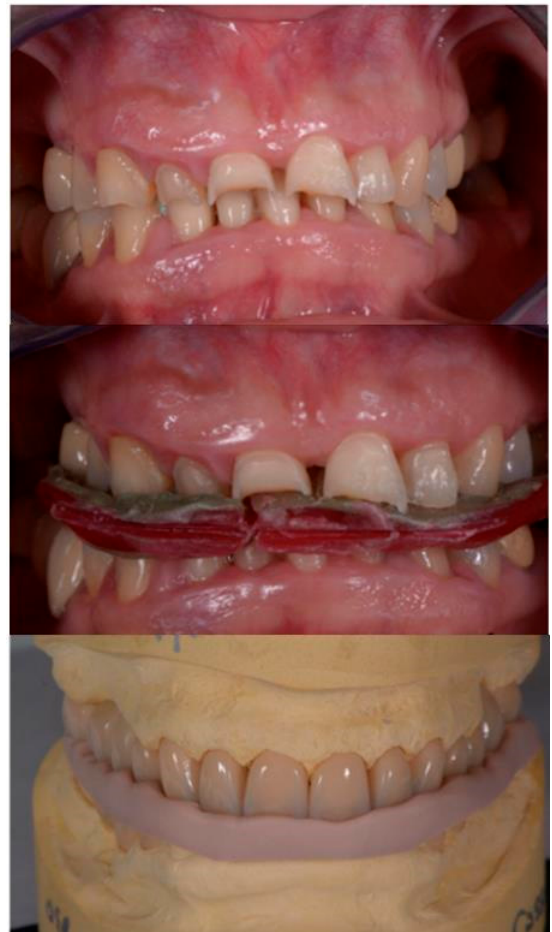
Figure 4. Traditional mockup and